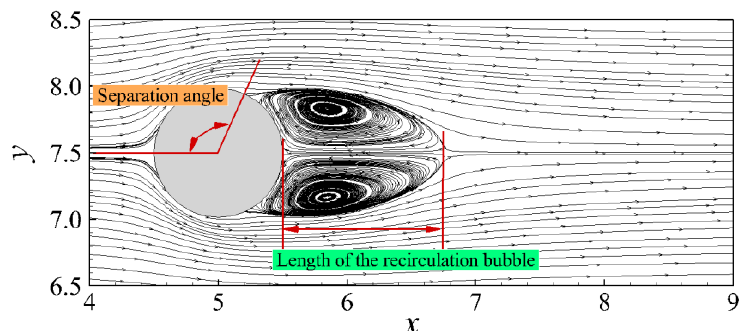
Figure 5. Axisymmetric streamlines past the sphere at Re = 150 .